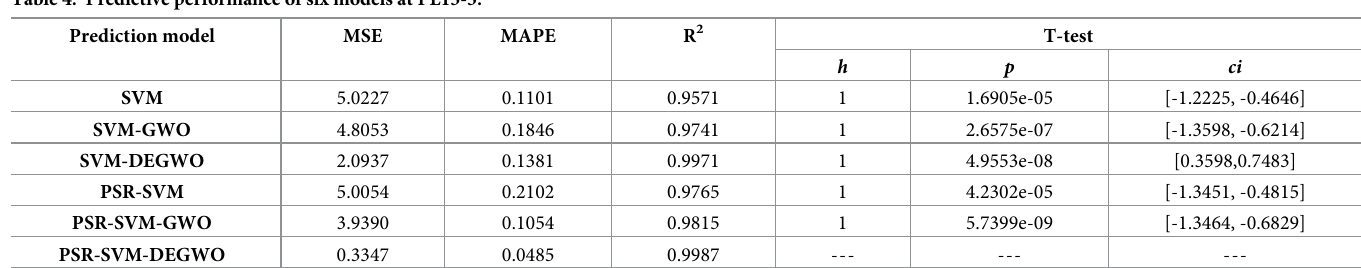
Table 4. Predictive performance of six models at PL13-3.